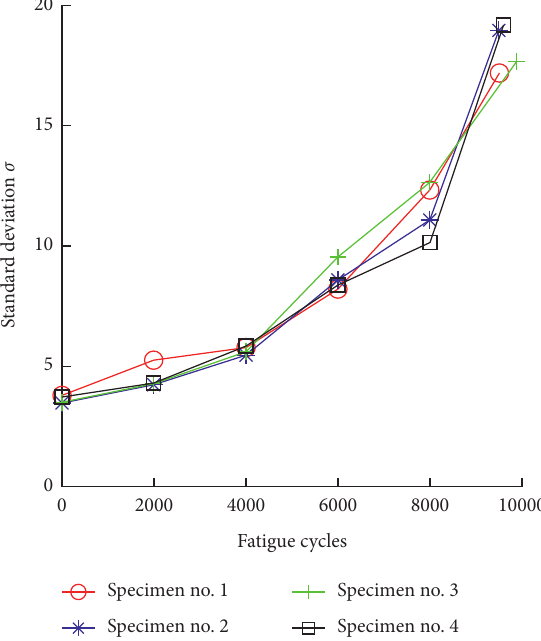
Figure 14: The variation curves of standard deviation δ. Table 1: Mean and variance values of each characteristic parameter (0